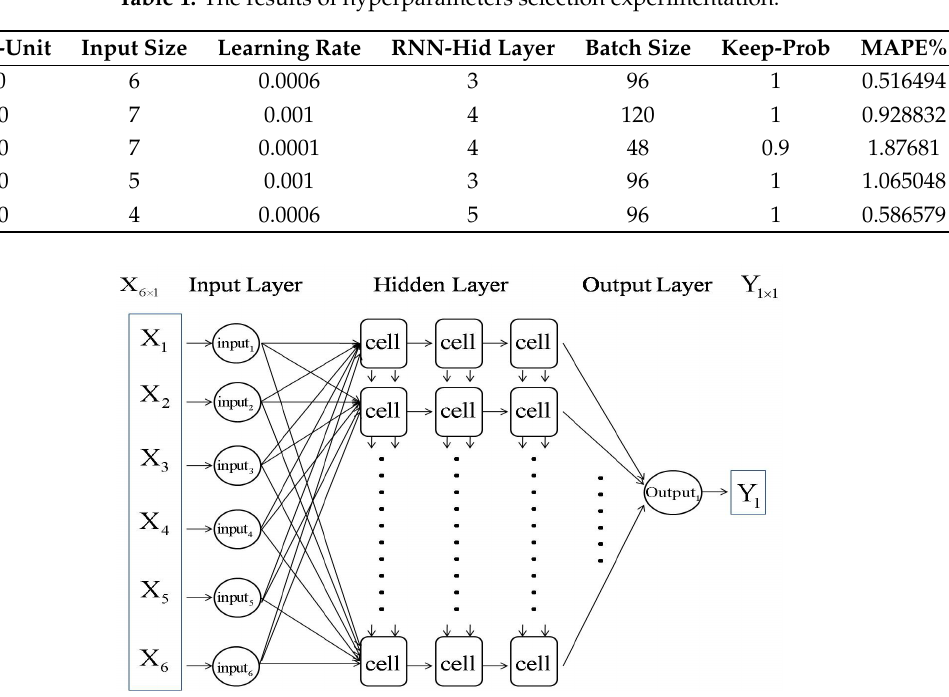
Table 1. The results of hyperparameters selection experimentation.